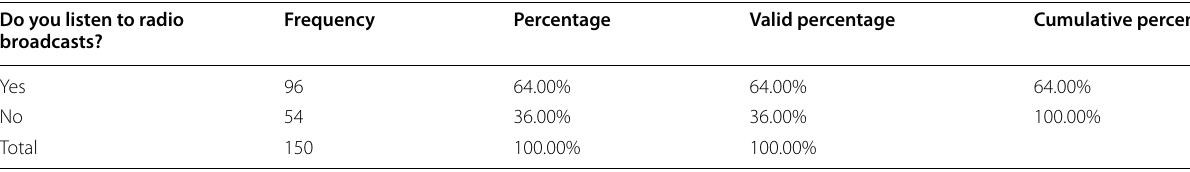
Table 8 Frequency, percentage of statement of listenership strength of radio stations (Audience response) Do you listen to radio broadcasts?